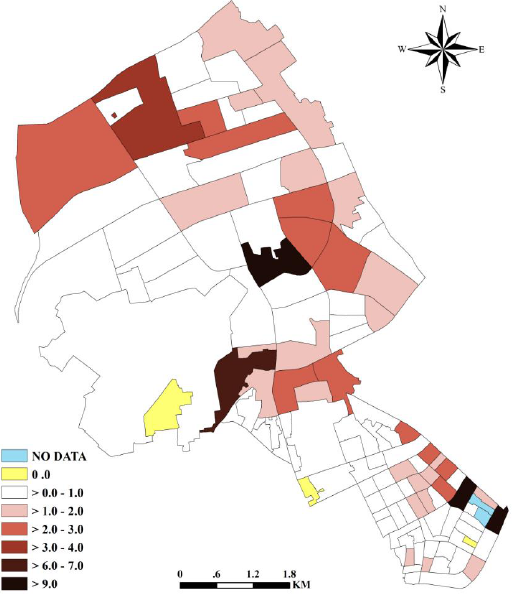
Figure 2. Map of standardized burglary ratios.